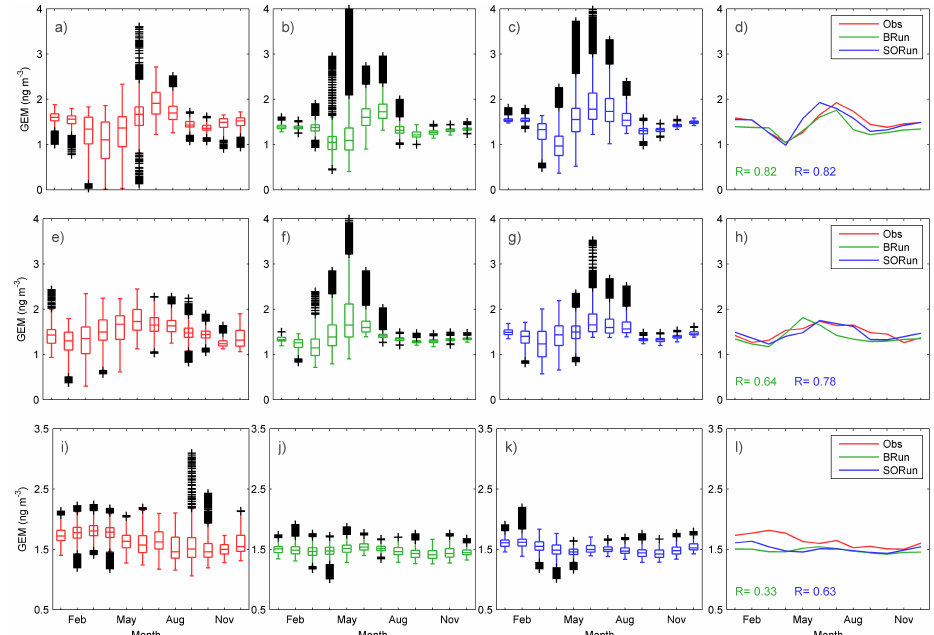
Fig. 4. The first three columns present boxes consisting of, for atmospheric surface-level GEM, each month’s median, 25th and 75th percentile concentrations (box’s centre line and boundaries). The whiskers represent the mean ±2.7 standard deviations, enclosing ∼ 99% of data points in a normally distributed dataset. Outliers are plotted using “+”. The first column (a, e, i) presents statistics based on observed concentrations. The second column (b, f, j) presents statistics based on BRun. The third column (c, g, k) presents statistics based on SORun. The fourth column provides monthly mean concentrations and correlation coefficients between the observed and simulated monthly means, following the color-coding of the legend. The first row (a–d) presents statistics for Alert, based on 5yr (2005–2009) of concentrations. The second row (e–h) presents statistics for Kuujjuarapik, based on 3yr (2007–2009) of concentrations. The third row (i–l) presents statistics for Point Petre, based on 3yr (2005–2007) of